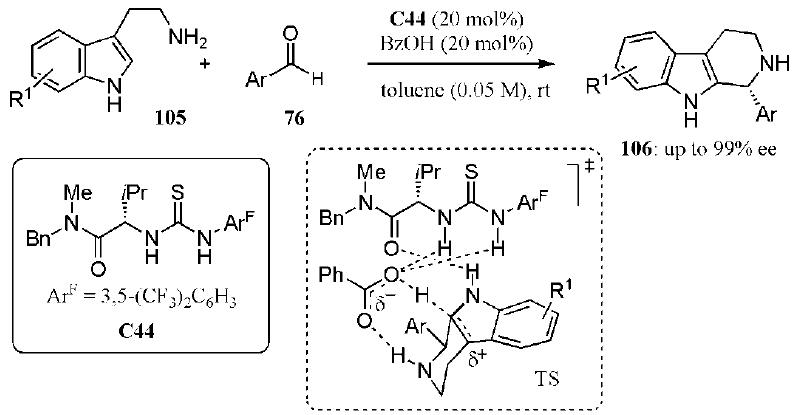
Figure 54. Enantioselective Pictet–Spengler reaction catalyzed by C44 [103,104].